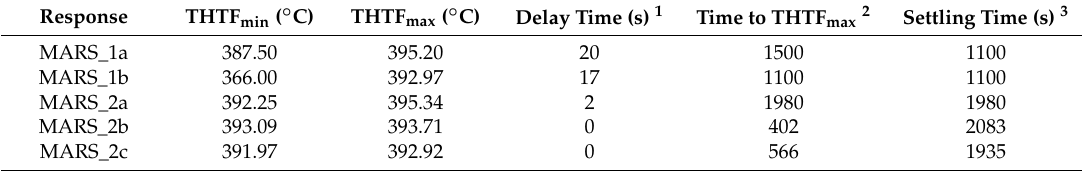
Table 3. First MARS models’ responses to a sharp step in DNI. THTF: heat transfer fluid